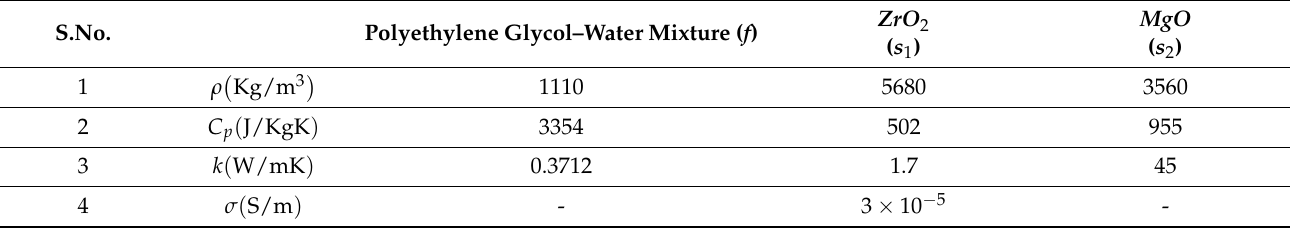
Table 1. Aspects of thermophysical relevant to HNF (Hossainy and Eid